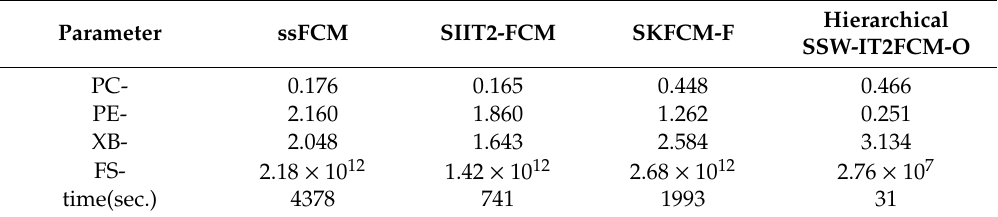
Table 6. Typical validity indices for four FSSC